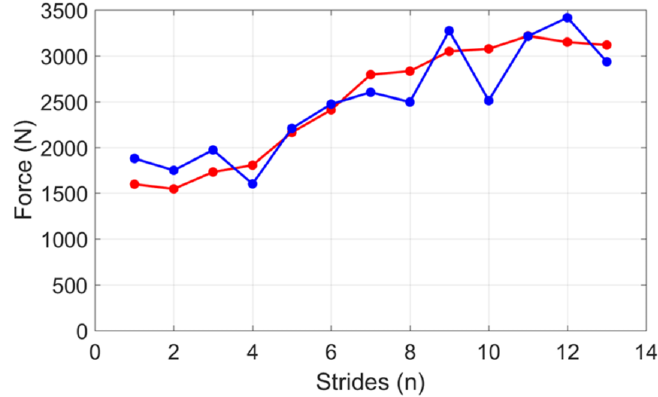
Figure 13. The vertical GRF measured by the force plate (red) compared to the one predicted by the IMUs (blue) for one subject, according to the method by [62].